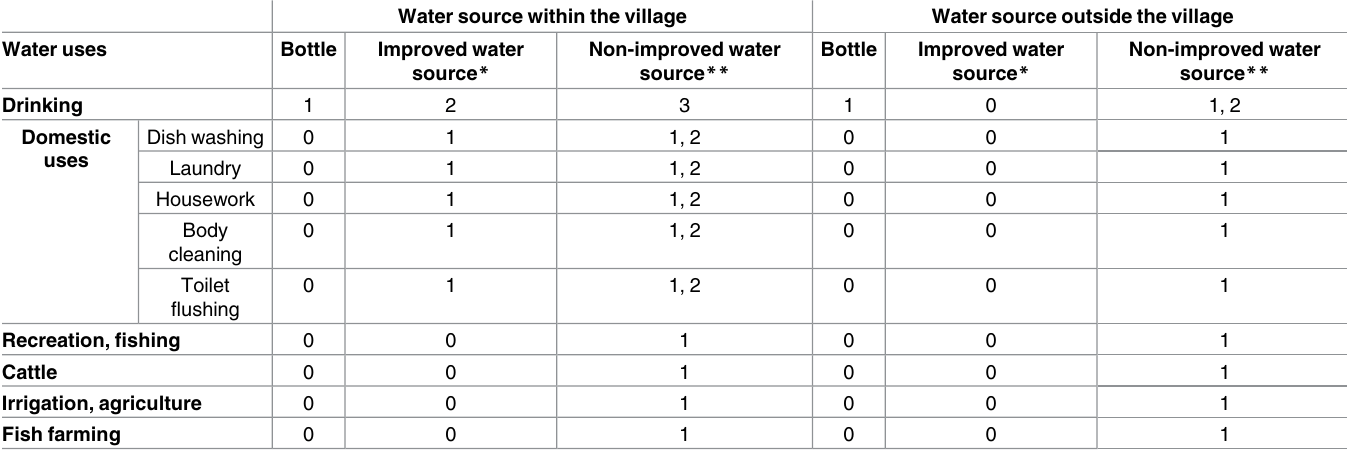
Table 6. Water sources options depending on water uses in the Luang Prabang rural area. Water sources options are ranked from 0 to 3, 0 meaning that the water source is not relevant for the considered use, 1 being the preferredwater source for the water use considered,provided it is financially or techni- cally available,2 being the alternative water source when option 1 is not available(e.g. a temporary shortage of bottled water) and 3 being the second alterna- tive water sources, when both options1 and 2 are not available(e.g. when the municipalwater fountain runs out of water duringthe hot season, or when it breaks down becauseof limestonedepositsin pipes). Two ranks given for one water source means that what is considered as an alternative water source for some villagerscan be considered as the main water source for